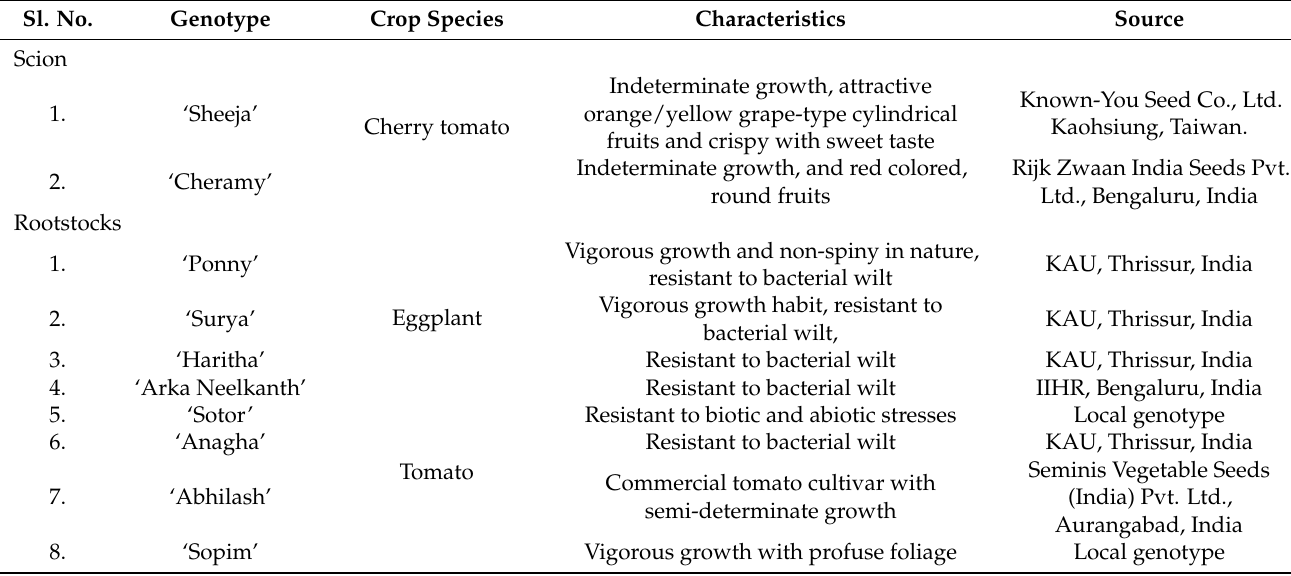
Table 1. Description of the scion and rootstock genotypes used in the